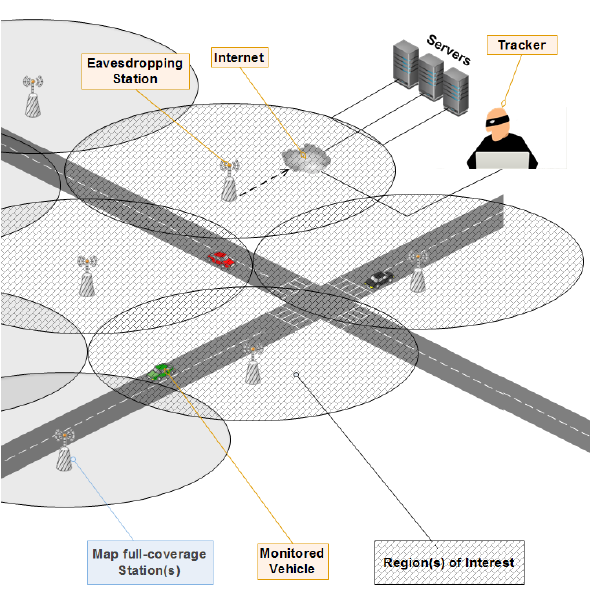
Figure 4. Threat model and its resources, capabilities, and